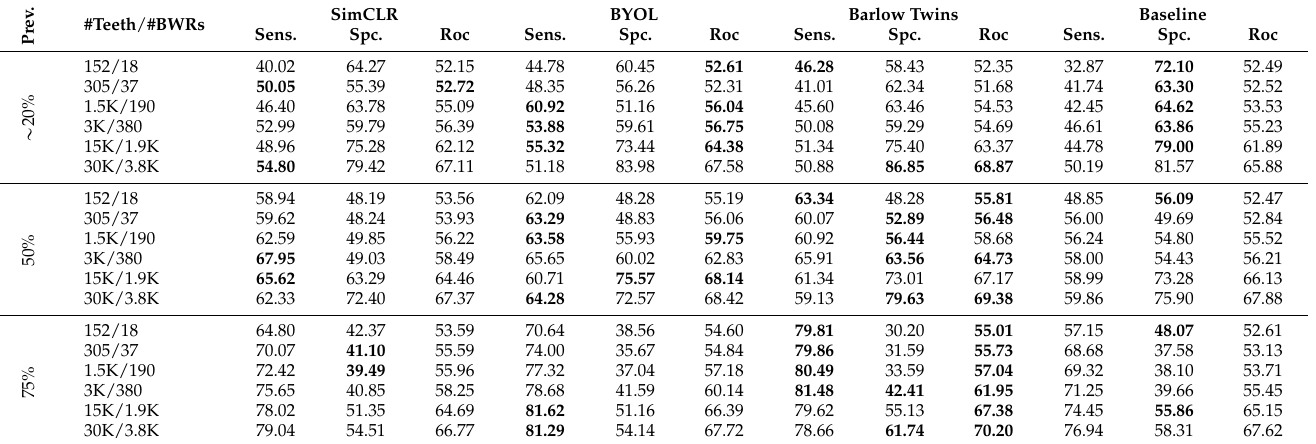
Table 2. Caries classification results when fine-tuning on varying quantities of labeled samples (numbers of #teeth/#BWRs). The results are grouped by the prevalence of the caries ( „ 20%, 50%, 75%). We highlight in bold the best models in each row (i.e., for each fine-tuning dataset